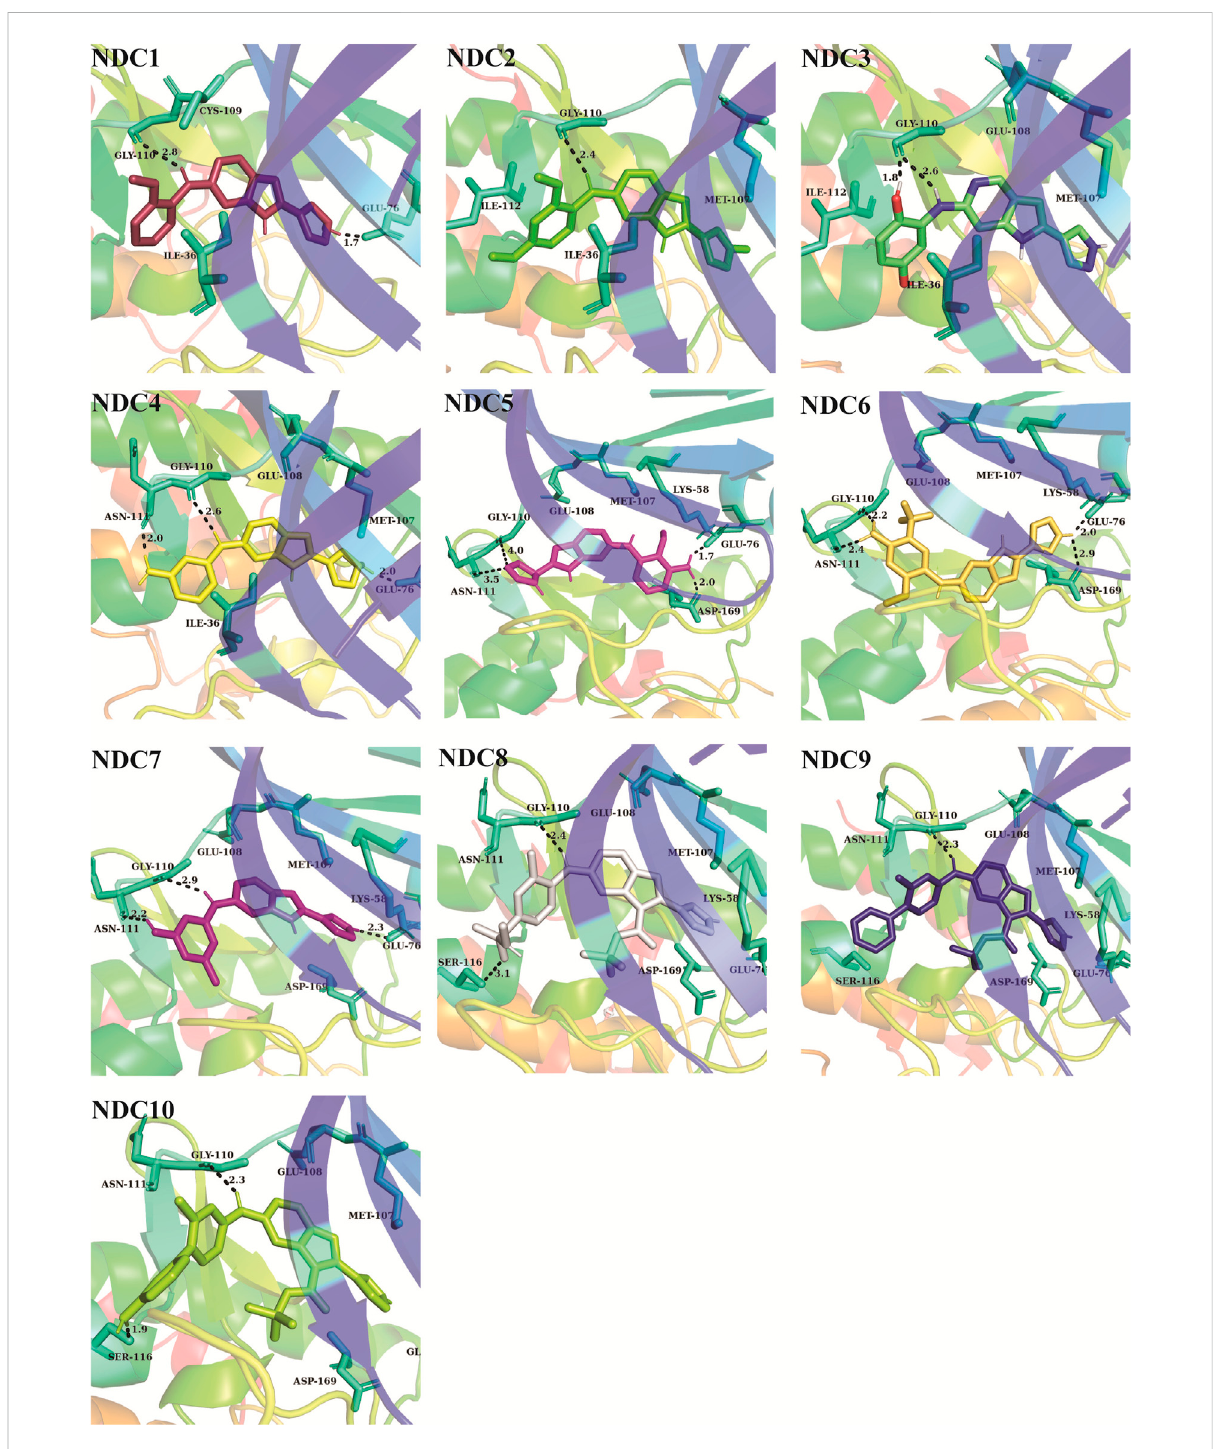
FIGURE 5 The binding interactions of newly designed compounds with the key residues of TTK binding pocket. The hydrogen bonds are denoted with black dash lines. The distance between the compounds and binding site residues is measured in Å.